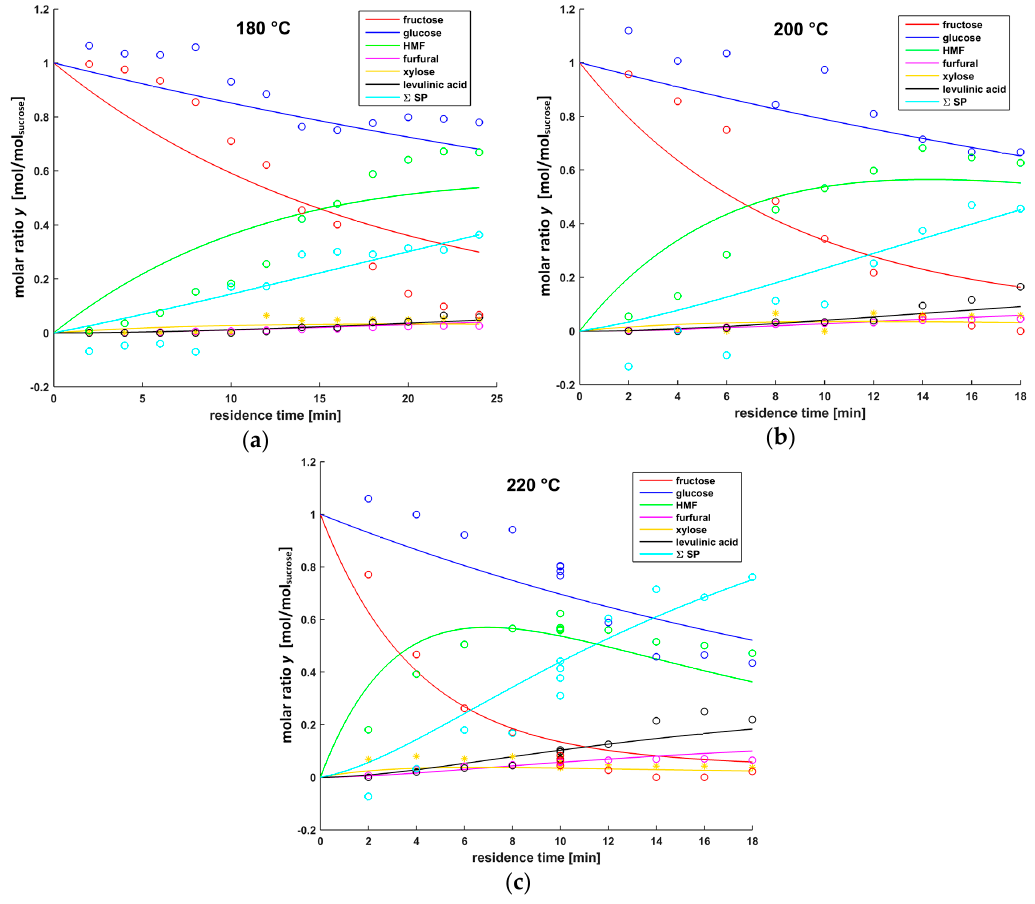
Figure 6. Kinetic plots of the acid-catalyzed conversion of sucrose at different residence times and temperatures of ( a ) 180 °C, ( b ) 200 °C, and ( c ) 220 °C. The molar ratios measured y i,meas are shown as data points and molar ratios calculated y i as lines. ∑ SP accounts for the sum of SP1, SP2, and SP3, as defined in Figure 2. Feedstock contained 2 wt % sucrose and 0.005 mol/L sulfuric acid.